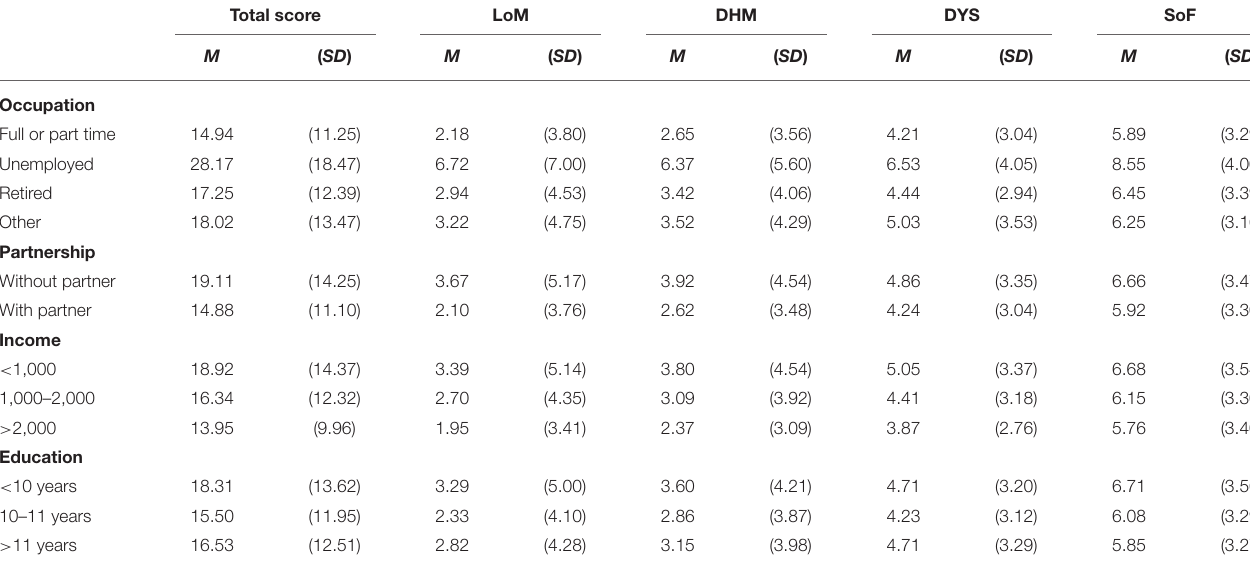
TABLE 5 | Group differences in sociodemographic variables regarding demoralization scores.